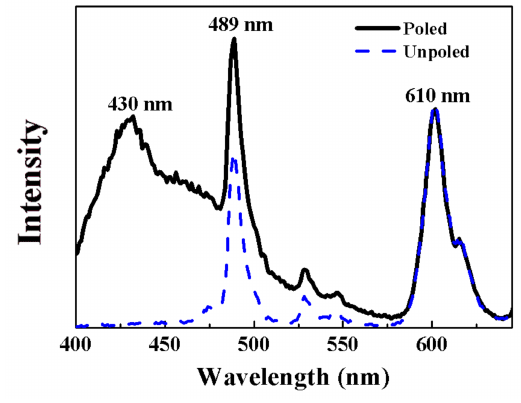
Figure 5. PL spectra of poled and unpoled BZT-0.5BCT ceramics with 0.2% Pr 3+ under 362 nm